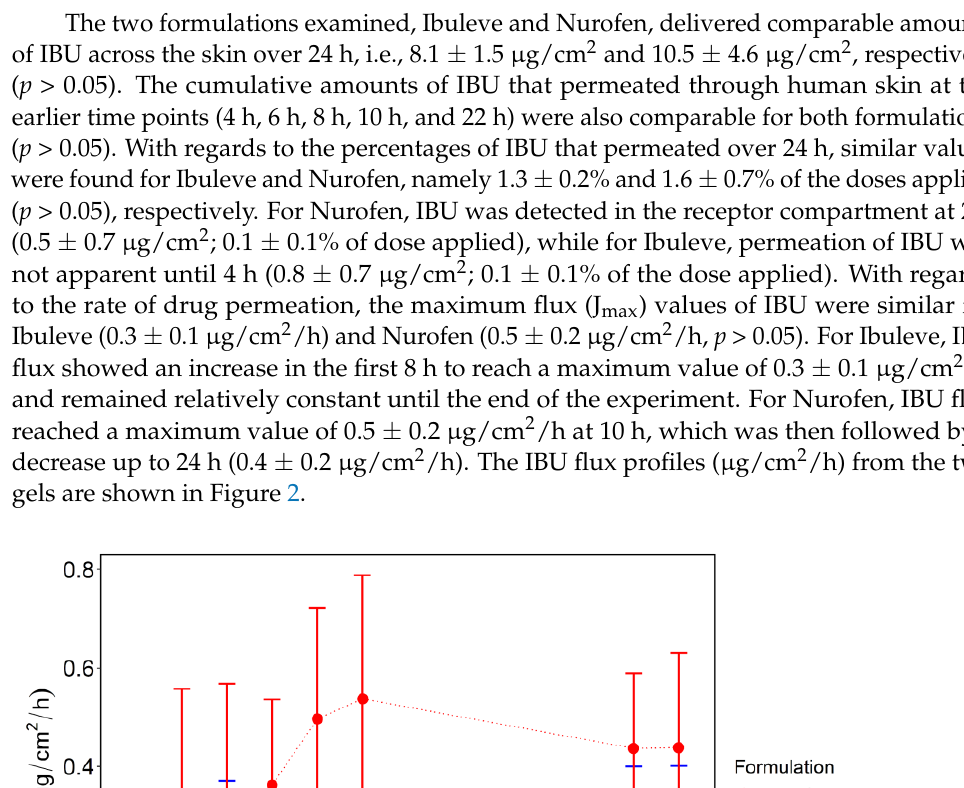
Figure 1. Permeation profiles of IBU over time for the commercially available formulations, Ibuleve and Nurofen, in human epidermis, expressed as ( A ) cumulative amounts (μg/cm 2 ) and ( B ) percent- ages (%) of the dose applied ( n = 5; mean ± SD).